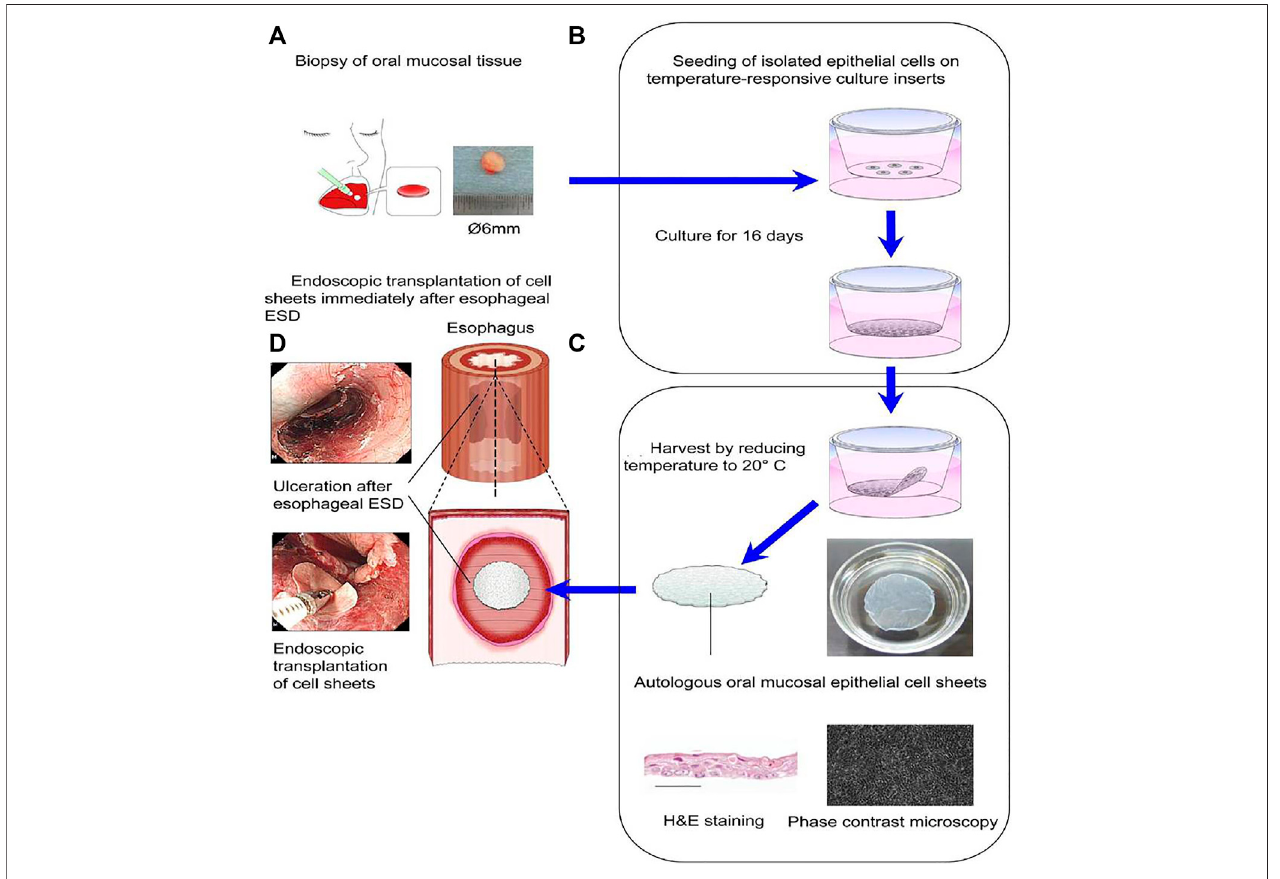
FIGURE 7 | The treatment of the esophageal defect after ESD by transplantation of cell sheets composed of autologous oral mucosal epithelial cells. (A) Oral mucosal epithelial cells (OMECs) were taken from the patients ’ oral cavity. (B) The OMECs were seeded on temperature-responsive culture inserts and cultured for 16 days. (C) CellsheetscomposedofOMECswereharvestedbyreducingtemperatureto20 ° C. (D) CellsheetscomposedofOMECsweretransplantedimmediatelyon the esophageal defect under endoscopy after ESD. Reproduced from Ohki and Yamamoto (2020). Copyright (2020), with permission from